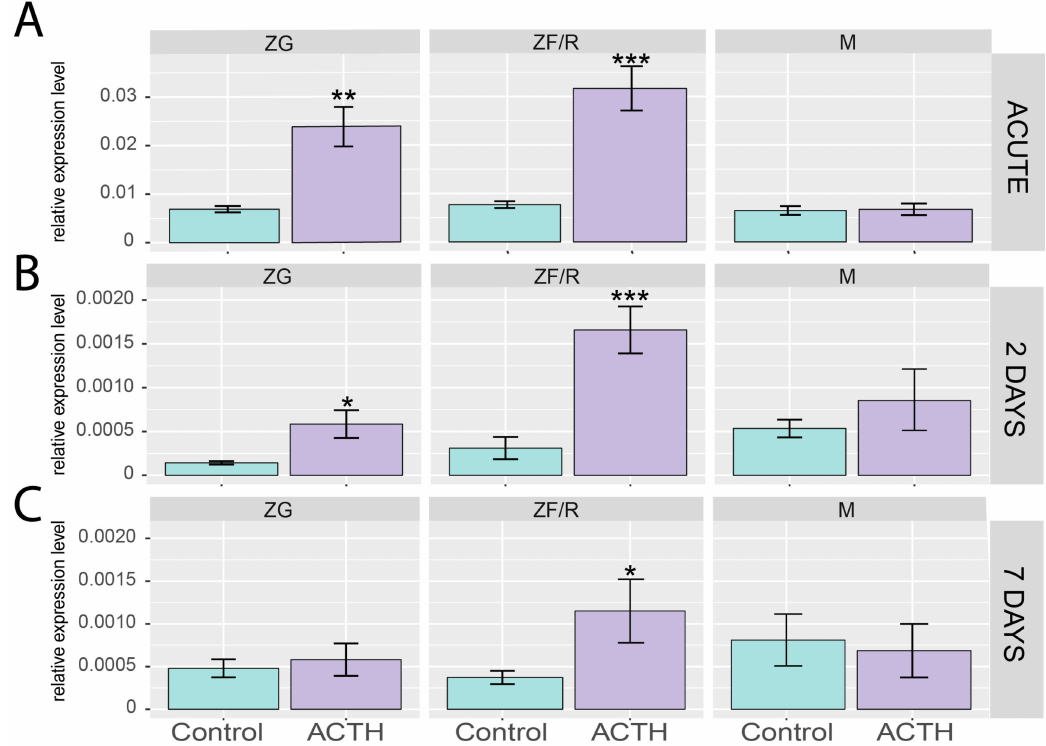
Figure 3. ACTH effects on Giot1 gene expression in zona glomerulosa (ZG), zona fasciculata/reticularis (ZF/R) and adrenal medulla (M) of adult male rats. Expression of Giot1 was measured by qPCR method after 1 h of i.p. ACTH administration ( A ) or long-term infusion of corticotropin (ALZET microosmotic pumps) for 2 days ( B ) and 7 days ( C ) (ACTH infusion rate 2 nmol/24 h/100 g). Bars represent means ± SEM ( n = 4). Statistically significant differences in relation to control group of each adrenal zones (Student’s t -test): * p < 0.05; ** p < 0.02; *** p <